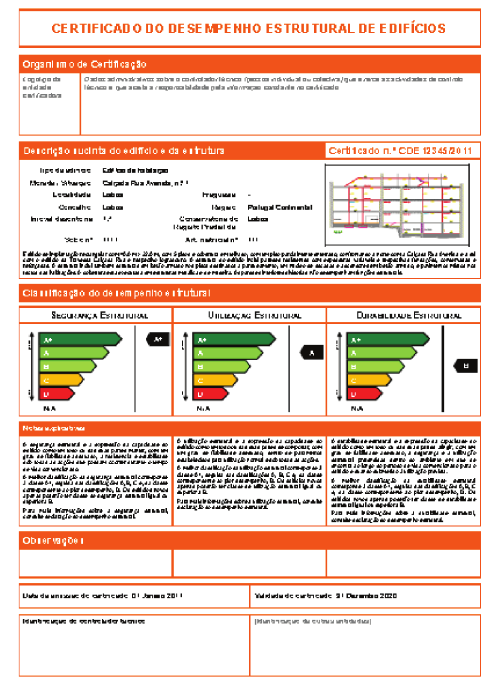
Fig. 2. Example of a structural performance